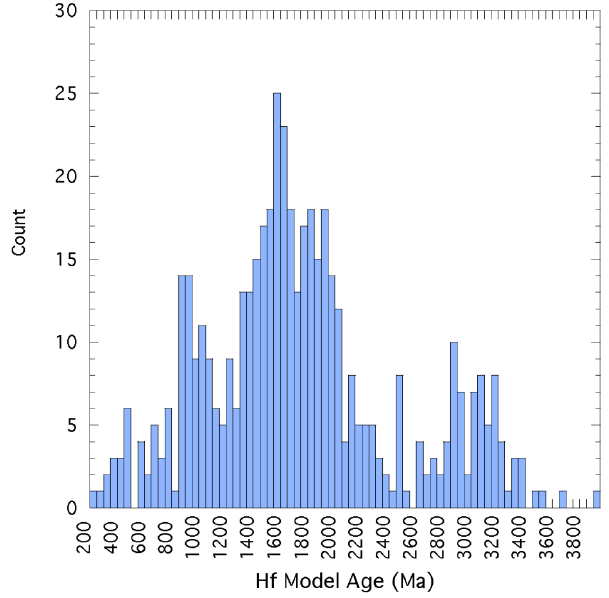
Figure 5. Hf model ages from detrital zircons from modern rivers in Laurentia. Data from Belousova et al. [5] and Condie et al. [13] and references therein.